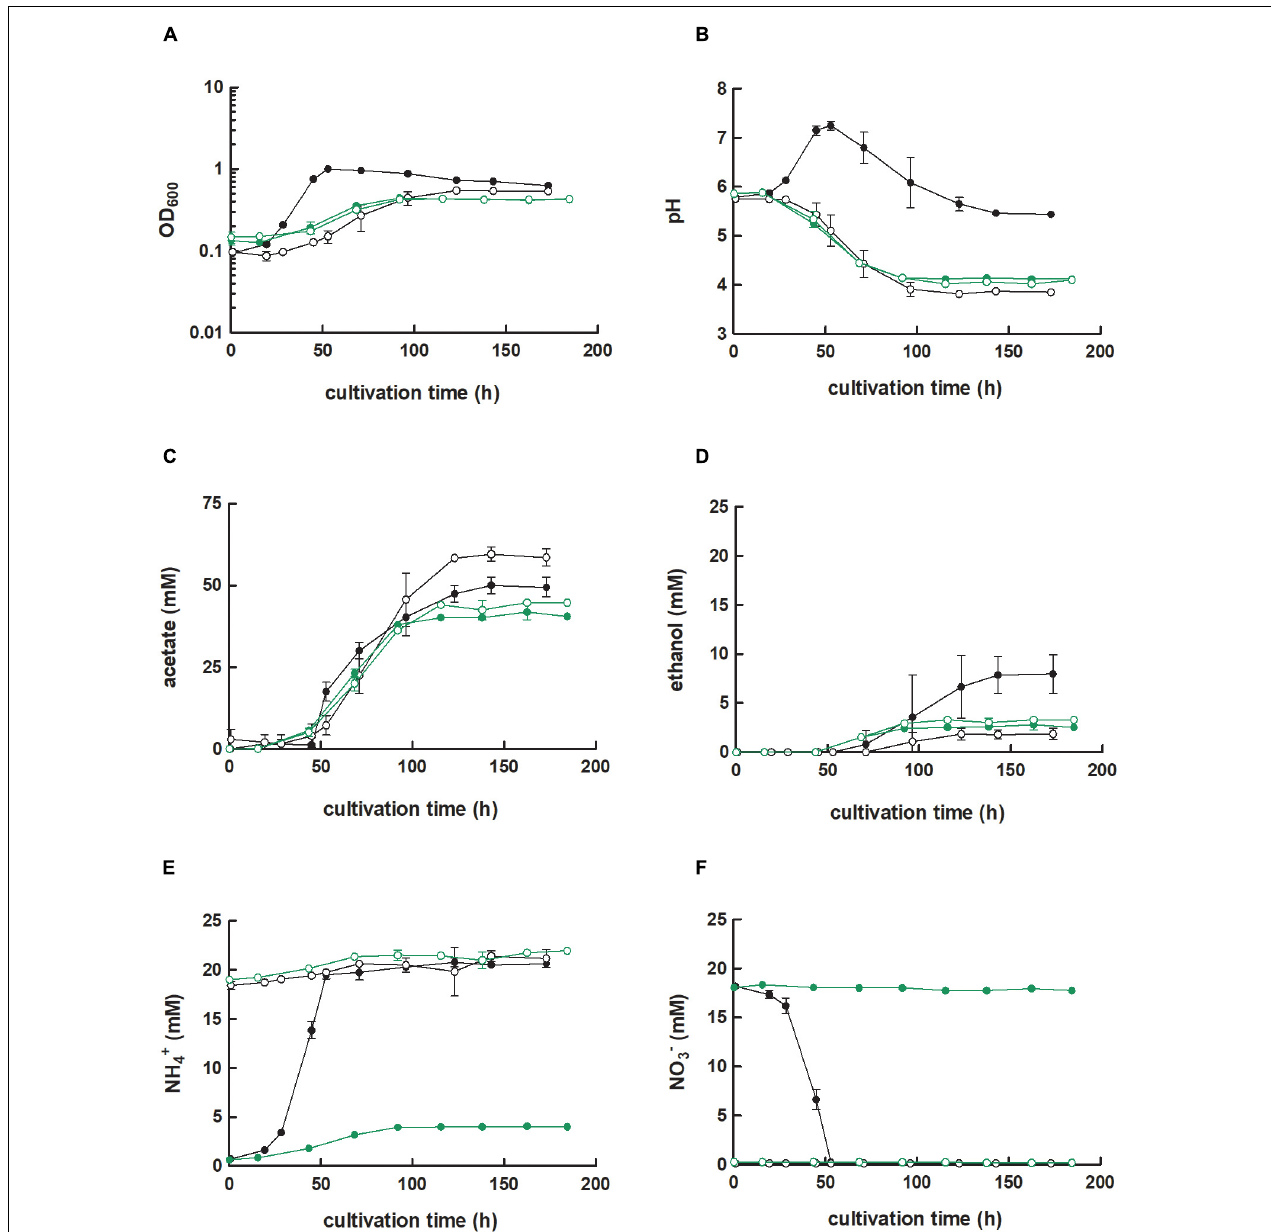
FIGURE 5 | Growth, pH behavior, nitrate reduction of C. ljungdahlii (cid:49) nar with H 2 and CO 2 . Cultures were grown in 100 mL PETC medium in 1 L bottles at 37 ◦ C and 150 rpm for 185 h. The headspace consisted of H 2 and CO 2 (80/20 vol-%) and was set to 0.5 bar overpressure. The medium contained either 18.7 mM nitrate ◦ ◦ (NO 3 − ) ( ) or 18.7 mM ammonium (NH 4 + ) ( ) as nitrogen source. The C. ljungdahlii WT data ( , ) from Figure 1 is given for comparison. All cultures were grown in biological triplicates, data is given as mean values, with error bars indicating the standard deviation. (A) Growth; (B) pH-behavior; (C) acetate concentrations; (D) (cid:32) (cid:32) ethanol concentration; (E) ammonium concentration; and (F) nitrate concentrations. (cid:49) nar, deletion of nitrate reductase gene cluster; rpm, revolutions per minute; CO 2 , carbon dioxide; and H 2 ,